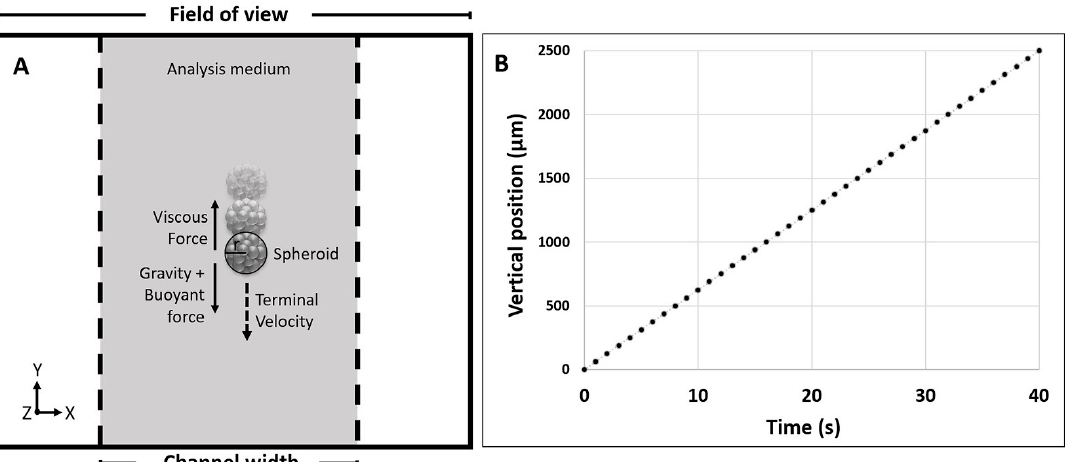
Figure 1. ( A ) Representation of the field of view captured by the detection unit. It shows the effect of the forces on a falling spheroid within the analysis channel; ( B ) Linear regression plot obtained for a repetition of an analyzed sample, reporting the vertical position on the Y-axis vs time ( R 2 = 0.9999). Differences between repetitions can be seen in Figure